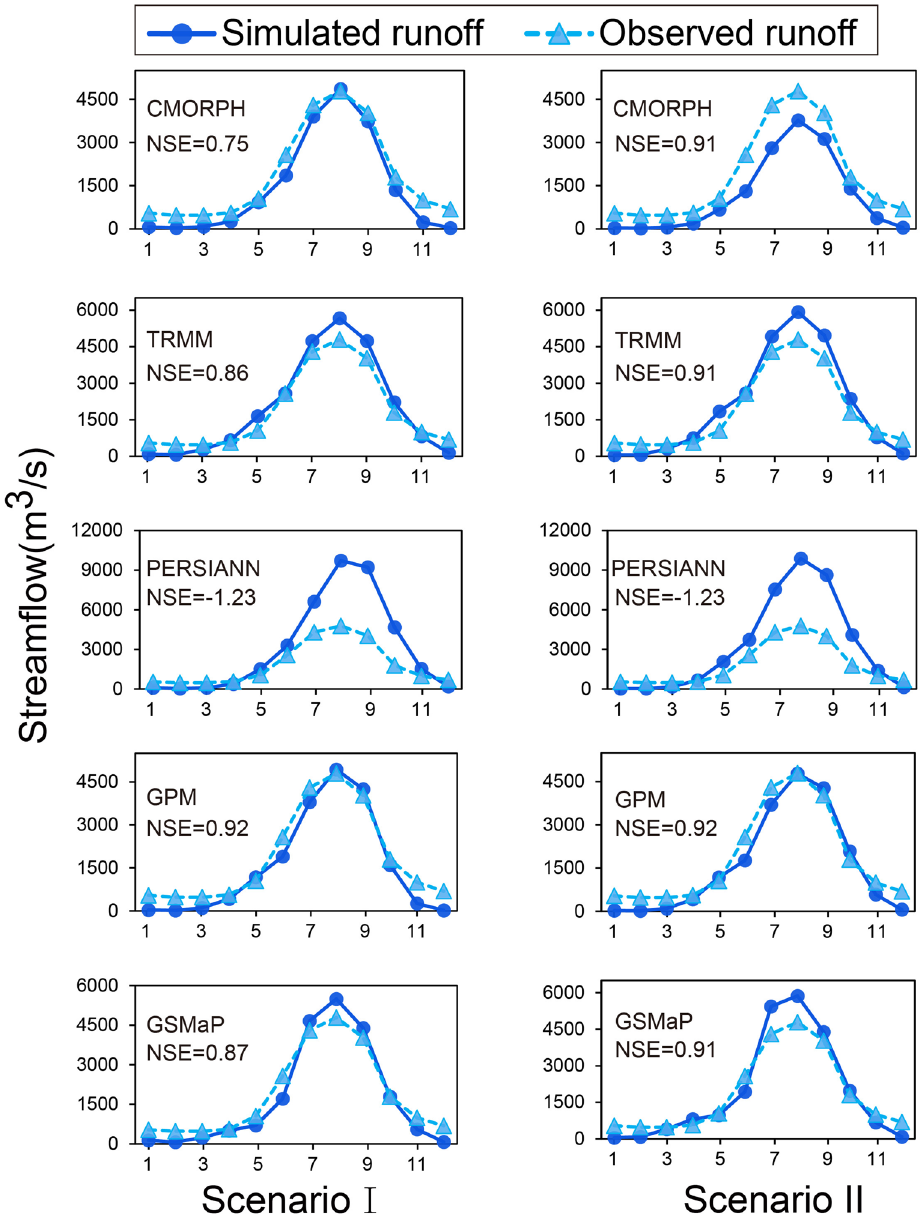
Figure 7. Multi-year average observed and simulated streamflow driven by different SPPs under Scenario I and Scenario II.